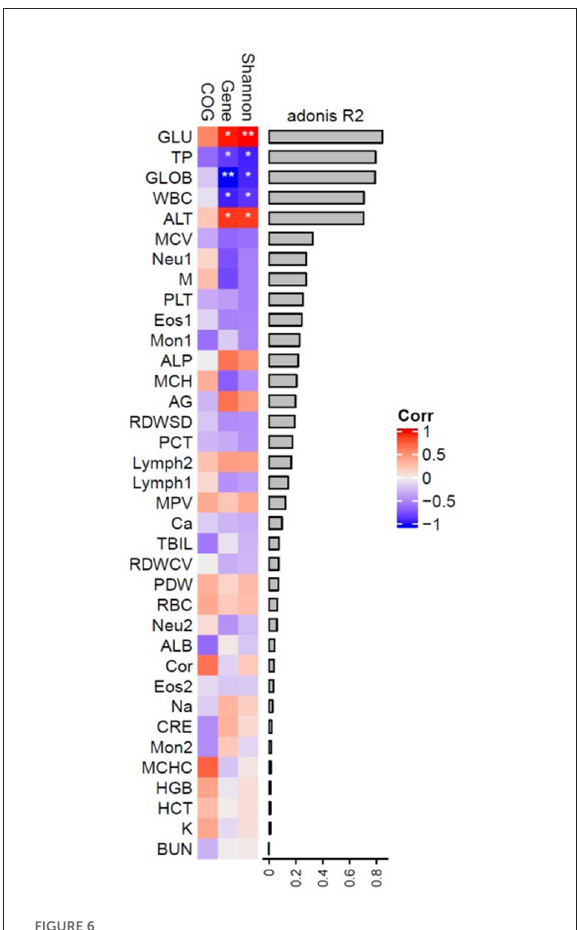
FIGURE6 Busbage phenotypic prediction.